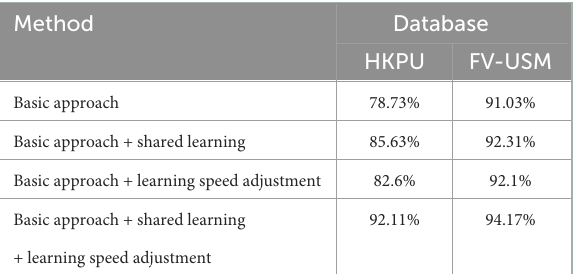
TABLE 7 Performance comparisons of the adjust learning speed method.